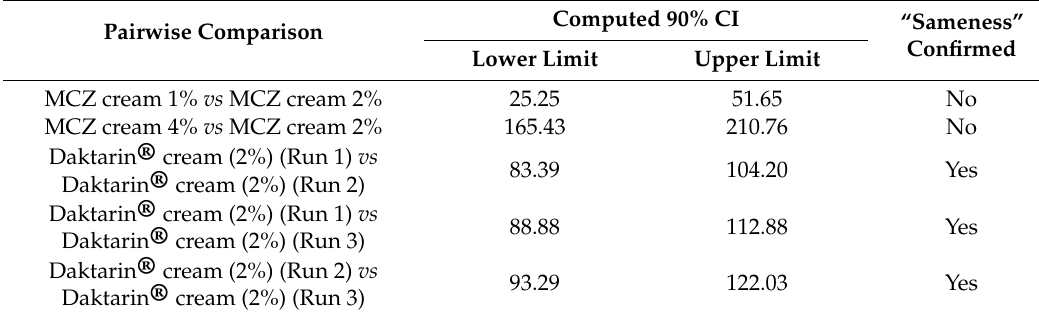
Table 3. Computed 90% confidence interval (CI) for the ratio of the release rate between two runs.